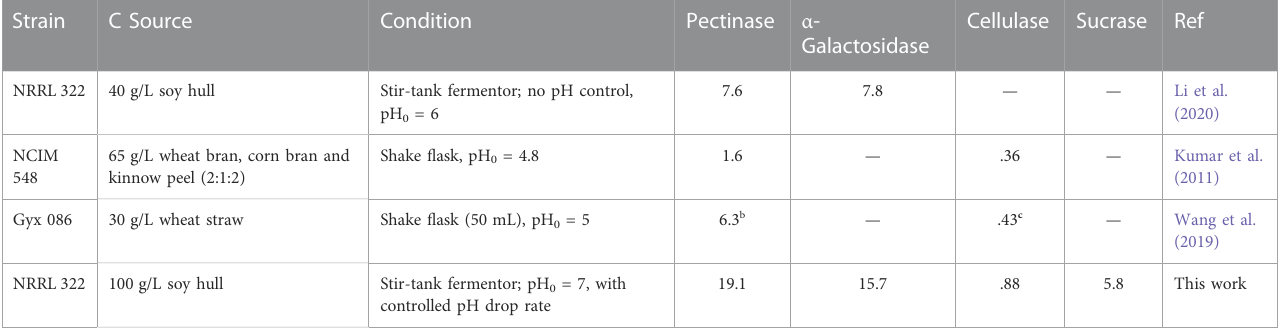
TABLE 2 Comparison of multi-carbohydrase activities a produced by submerged fermentation of Aspergillus niger . Strain C